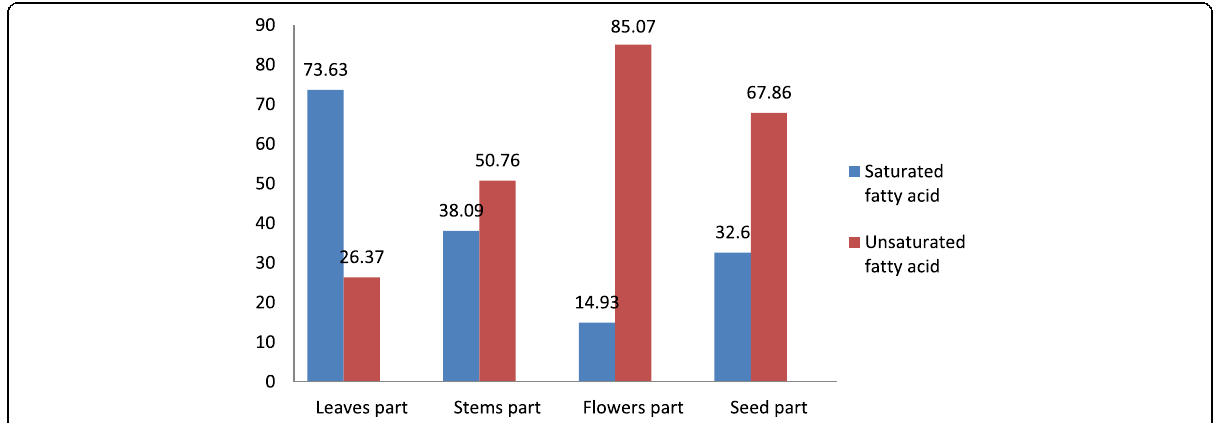
Fig. 2 GC-MS analysis of fatty acid of various parts of Cassia sophera Linn